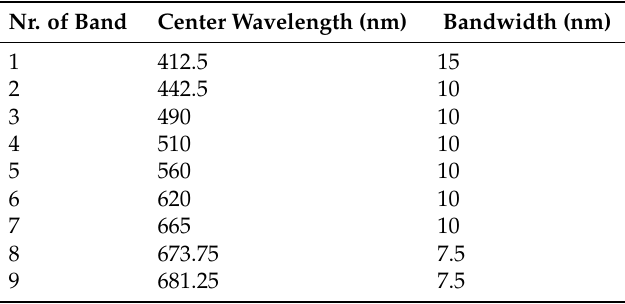
Table 2. Summary of the Sentinel 3A OLCI spectral